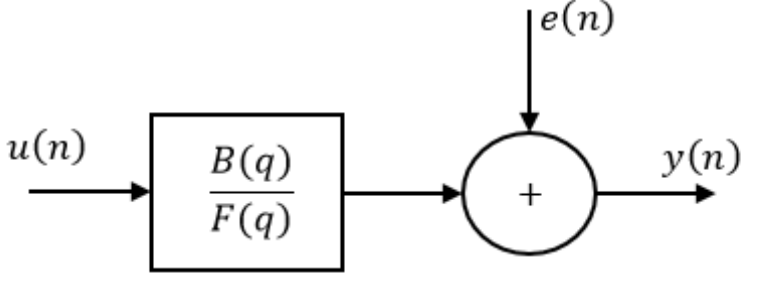
Figure 2. Signal flow of OE model.